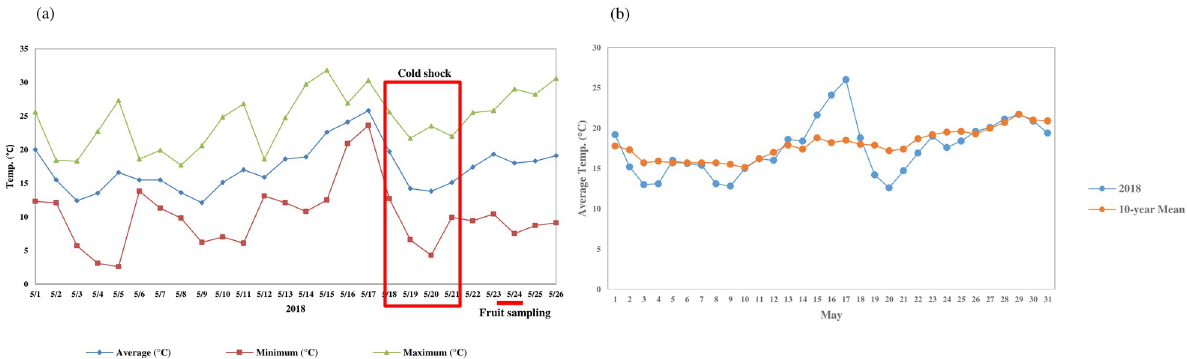
Fig 1. Meteorological data at the experimental plot of the Apple Research Institute, Gunwi (lat. 36.28˚N, long. 128.47˚E). (a) Change in daily minimum, mean, and maximum temperature during May of 2018. (b) Comparison of daily mean temperatures to 10-year annual mean.